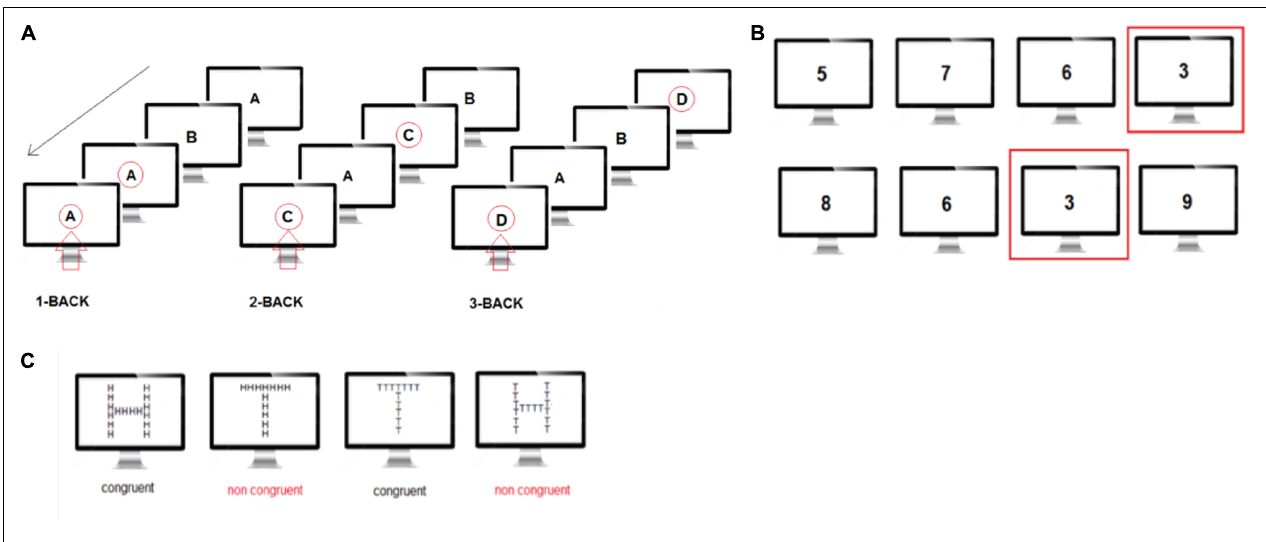
FIGURE 4 | (A) N-back task: visual illustration of the three levels of the n-back task. The red arrow indicates when the subject has been instructed to press the space key. (B) The Sustained Attention to response task (SART) is designed to measure a person’s ability to withhold responses to infrequent and unpredictable stimuli during a period of rapid and rhythmic responding to frequent stimuli. (C) The local-global task measures the ability to focus attention on a specific feature of a stimulus, either global or local, while resisting distraction from other features and is thought to be a relatively broad measure of conflict